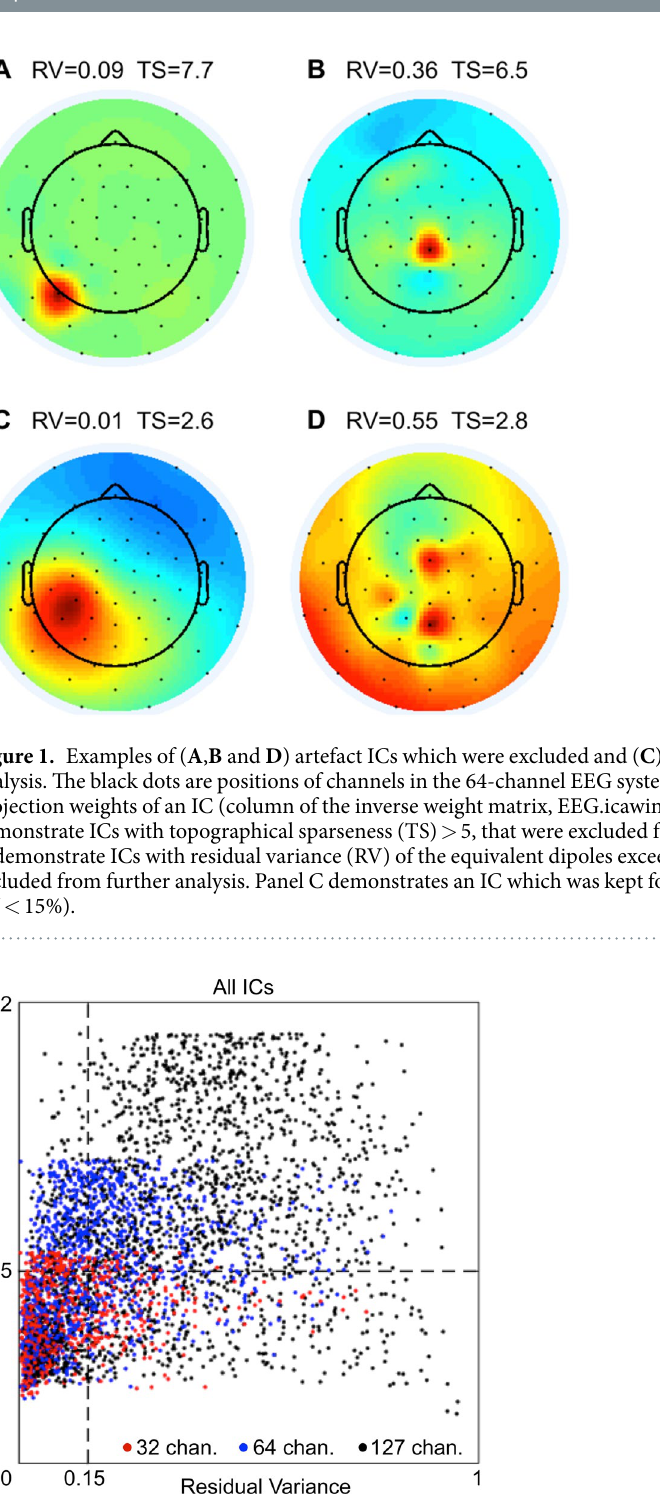
Figure 2. Scatter plot of Topographical Sparseness and Residual Variance values of all ICs in the study. Each dot represents an IC. X-axis = residual variance of an equivalent dipole of the IC. Vertical dotted line shows the residual-variance threshold = 0.15 (15%). Y-axis = topographical sparseness (TS) of an IC. Horizontal dotted line shows the TS threshold = 5. The number of all ICs from all recorded sessions in the study amounts to 4169 ICs, which consist of the following three groups: 672 ICs from 32-channel datasets (red dots), 1344 ICs from 64-channel datasets (blue dots), and 2153 ICs from 127-channel datasets (black dots). ICs in the lower left rectangle in the scatter plot were selected for further data